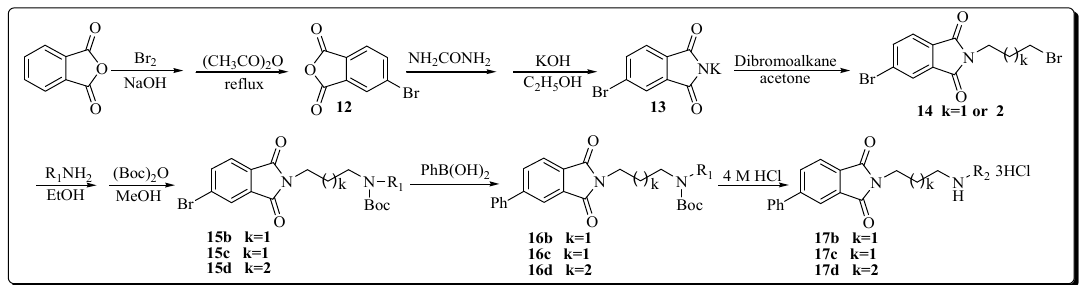
Scheme 2. Synthetic protocol of target compounds 17b – d (R 1 = N -Boc protected polyamine chains; R 2 = deprotected polyamine chains).